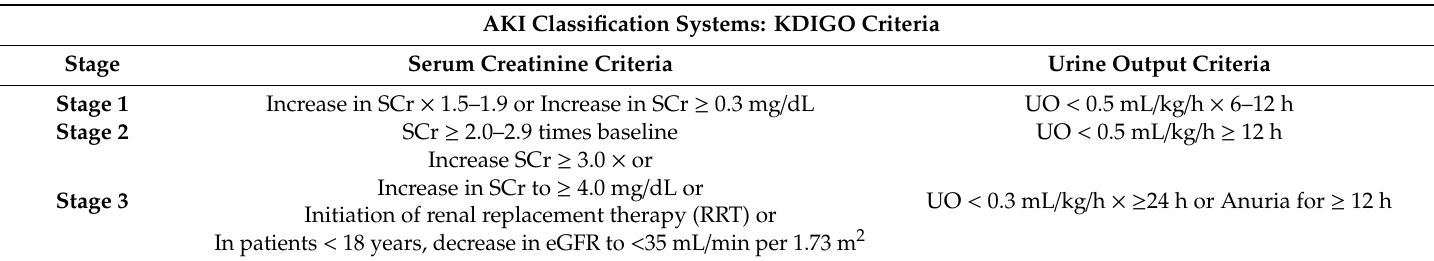
Table 4. AKI staging according to Kidney Disease: Improving Global Outcomes (KDIGO) criteria (adapted from reference [36]). AKI Classification Systems: KDIGO